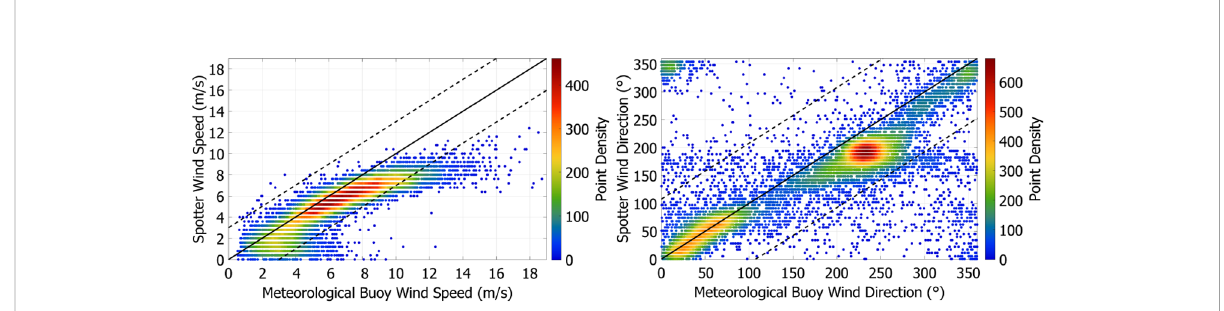
FIGURE 10 Density scatter plots of wind speed (left) and wind direction (right) recorded by the meteorological buoy and Spotter wave buoy. The solid black line through the origins shows a 1:1 relationship between the two buoys; the dashed black lines show one standard deviation for the meteorological buoy from the 1:1